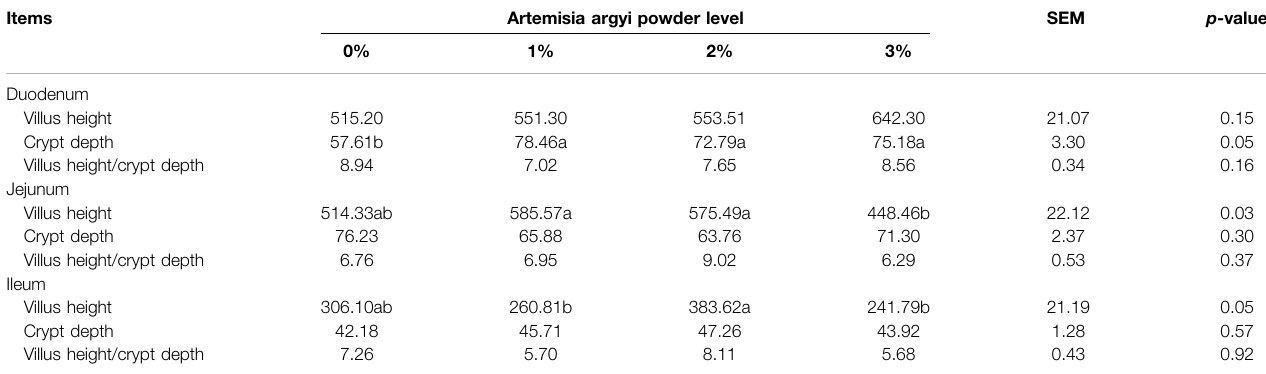
TABLE 7 | Effects of Artemisia argyi on Intestinal Histological Morphology of Roman Laying Hens ( μ m). Items Artemisia argyi powder